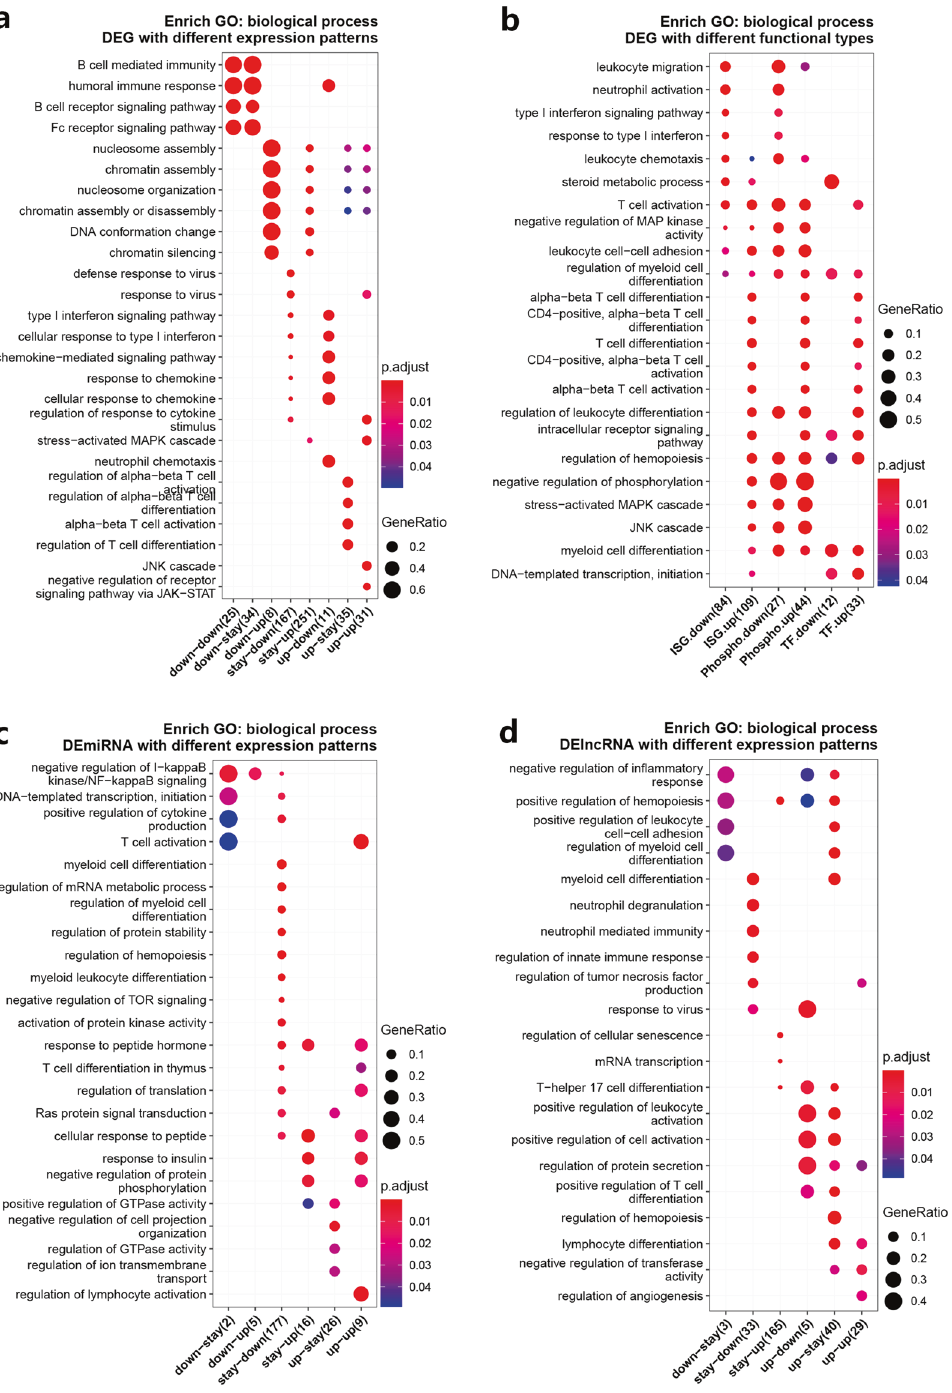
Fig. 4 Gene ontology (GO) enrichment analysis identi fi ed T cell immunity as the main regulatory target during the recovery of COVID-19. a GO enrichment results of DEGs in 8 differential expression clusters de fi ned in Fig. 2b. The numbers of signi fi cantly enriched genes in each cluster were included in parentheses. b GO enrichment results of interferon-stimulated genes (ISG), transcription factor genes (TF), and phosphorylation regulatory genes (Phospho) in DEGs. c , d GO enrichment results of the genes targeted by DEmiRNAs ( c ) and DElncRNAs ( d ) in 6 differential expression clusters de fi ned in Fig. 2c. The bubble size indicates the gene enrichment ratio (Generatio) of a biological process GO term, with color maps the FDR value (p.adjust) of the enrichment